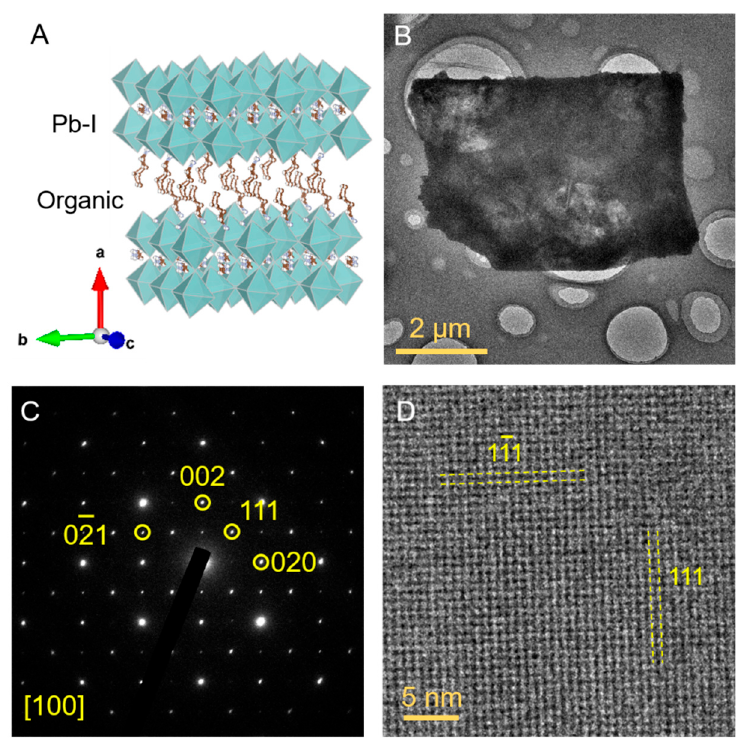
Figure 1. ( A ) Structural schematic of layered perovskite BA 2 FAPb 2 I 7 /BA 2 MAPb 2 I 7 where partial organic chains are not shown for clear demonstration; ( B ) low magnification image of 2D BA 2 FAPb 2 I 7 sheets and its corresponding SAED in ( C ). ( D ) average background subtraction filtered (ABSF) high-resolution transmission electron microscopy (HRTEM) image of BA 2 FAPb 2 I 7 along [100] zone axis.